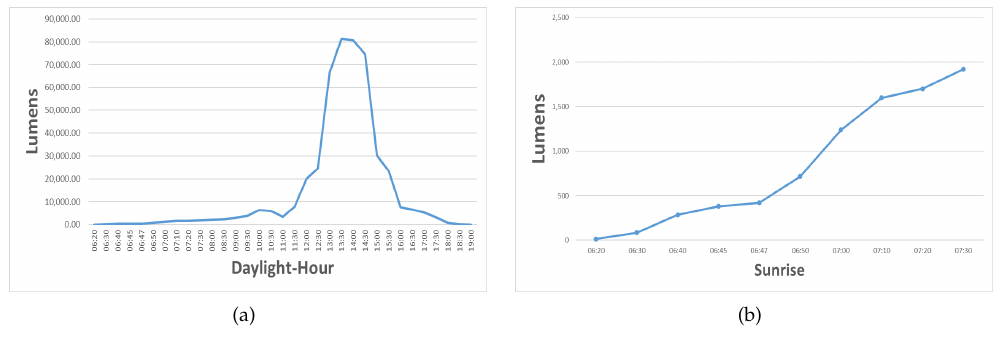
Figure 12. Characteristic curve of I v captured outdoors: ( a ) Daylight-Hour Graph, sample every 30 min and ( b ) One-Hour Graph, sample taken every 10 min, during the